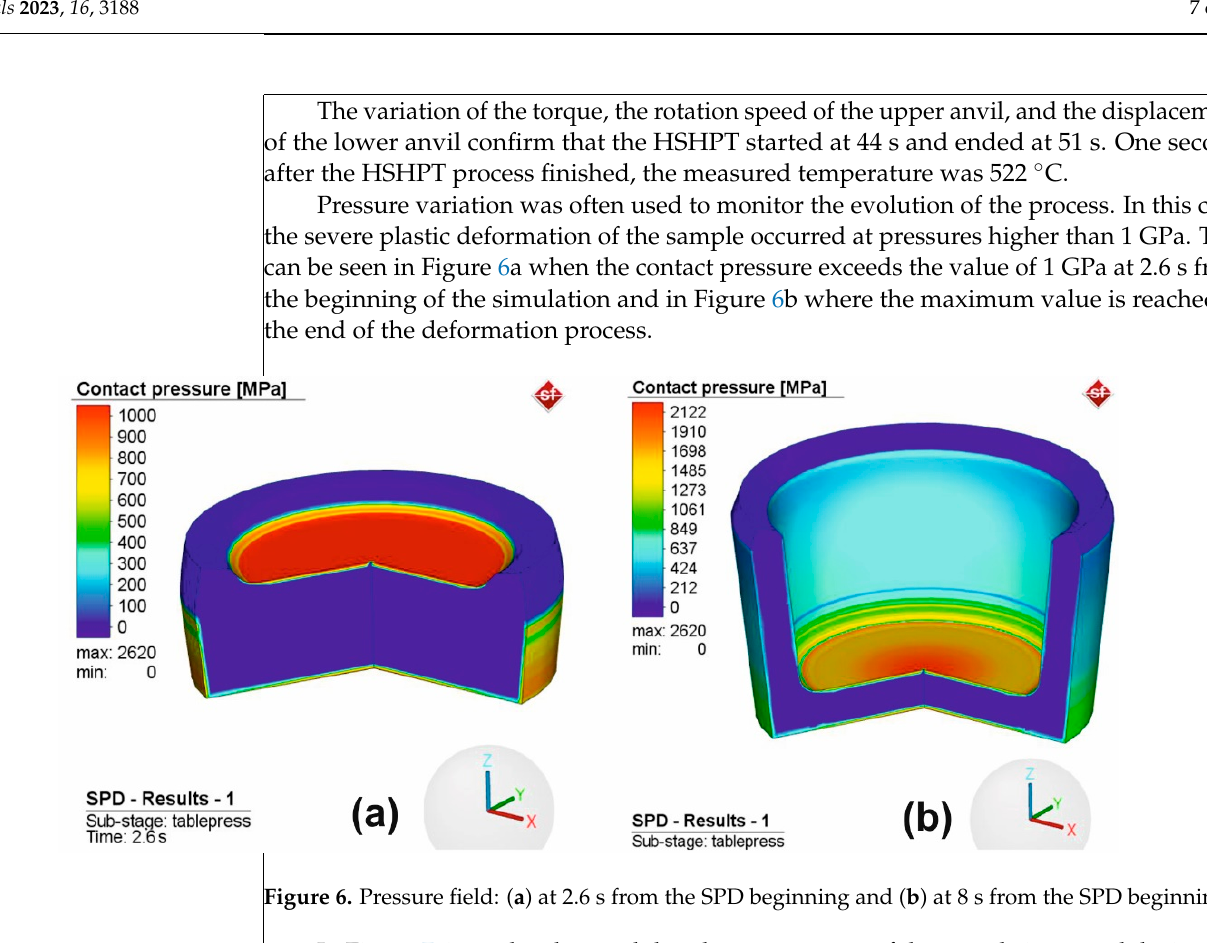
Figure 5. HSHPT experimental parameters.